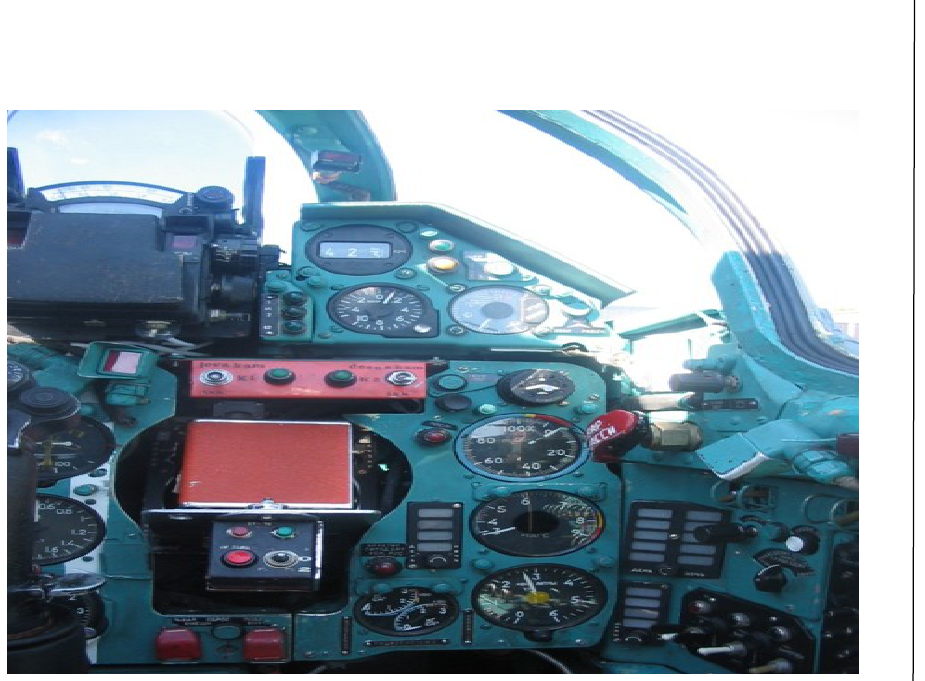
Figure 4b – A20 installed on an MIG 21 (Arhiv Vazduhoplovnog opitnog centra, 2016) centra, 2016)